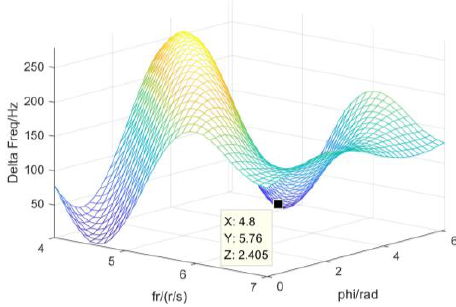
Figure 14. The variety of Figure 14. The variety of M ( 3, Ω , ξ ) values. Figure 14. The variety of